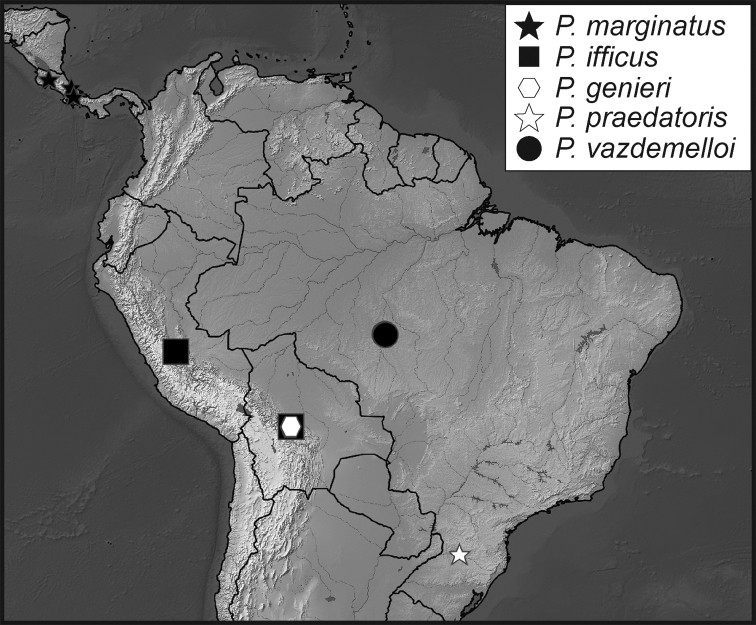
Collecting records for Phelister
vazdemelloi (black circles), P.
praedatoris (white star), P.
ifficus (black squares), P.
genieri (hexagon), and P.
marginatus (black stars).